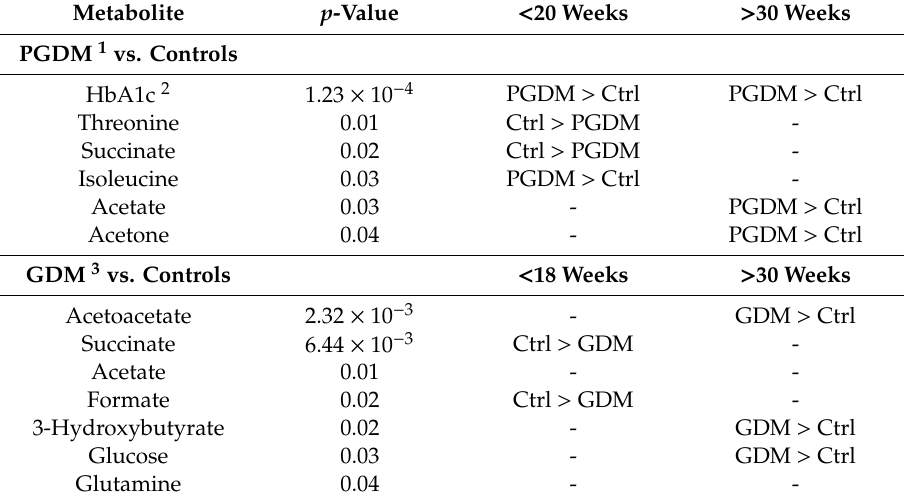
Table 3. Metabolites with Significant Interaction E ff ects in Maternal Serum in PGDM or GDM throughout